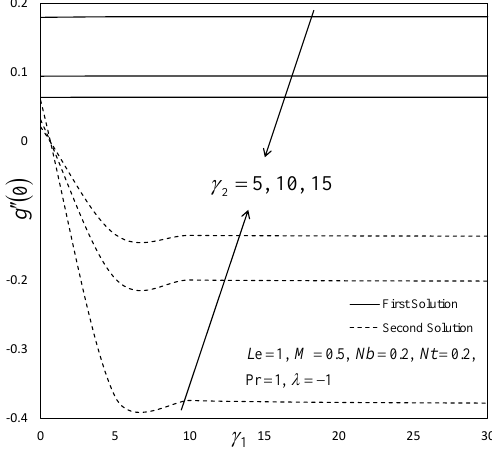
Figure 11. Variations of g (cid:48)(cid:48) ( 0 ) towards γ 1 for selected values of γ 2